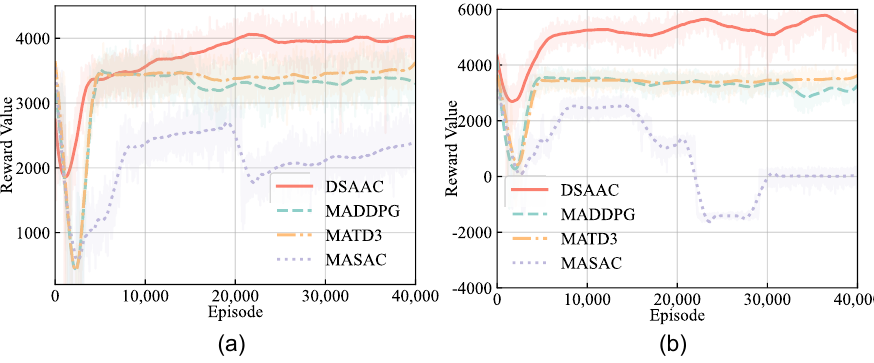
Figure 10. The training curve of reward for differents number of GUs: ( a ) 6 UAVs serving 20 GUs;